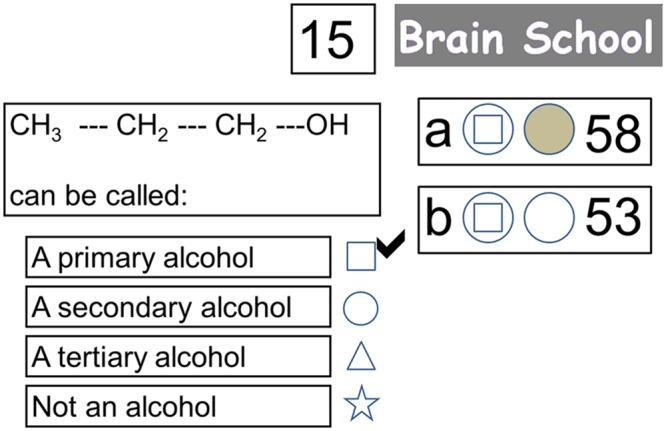
Screen shot of interface when participants are receiving feedback on their response to the question (with the correct answer now indicated with a tick). The response (as shown by the symbol in the first circle) of both the participant being scanned (player “a”) and their competitor in the control room (player “b”) was correct. Since the participant being scanned had decided to game their points (as shown by the filled second circle) he/she may now win 30 points or no points depending on a wheel of fortune that is about to appear. Their competitor did not decide to game their points, so they will receive 15 points for their correct answer irrespective of the wheel of fortune.